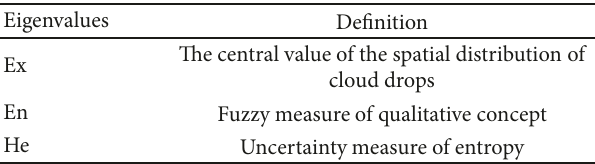
Table 3: Definition of the digital eigenvalues of the